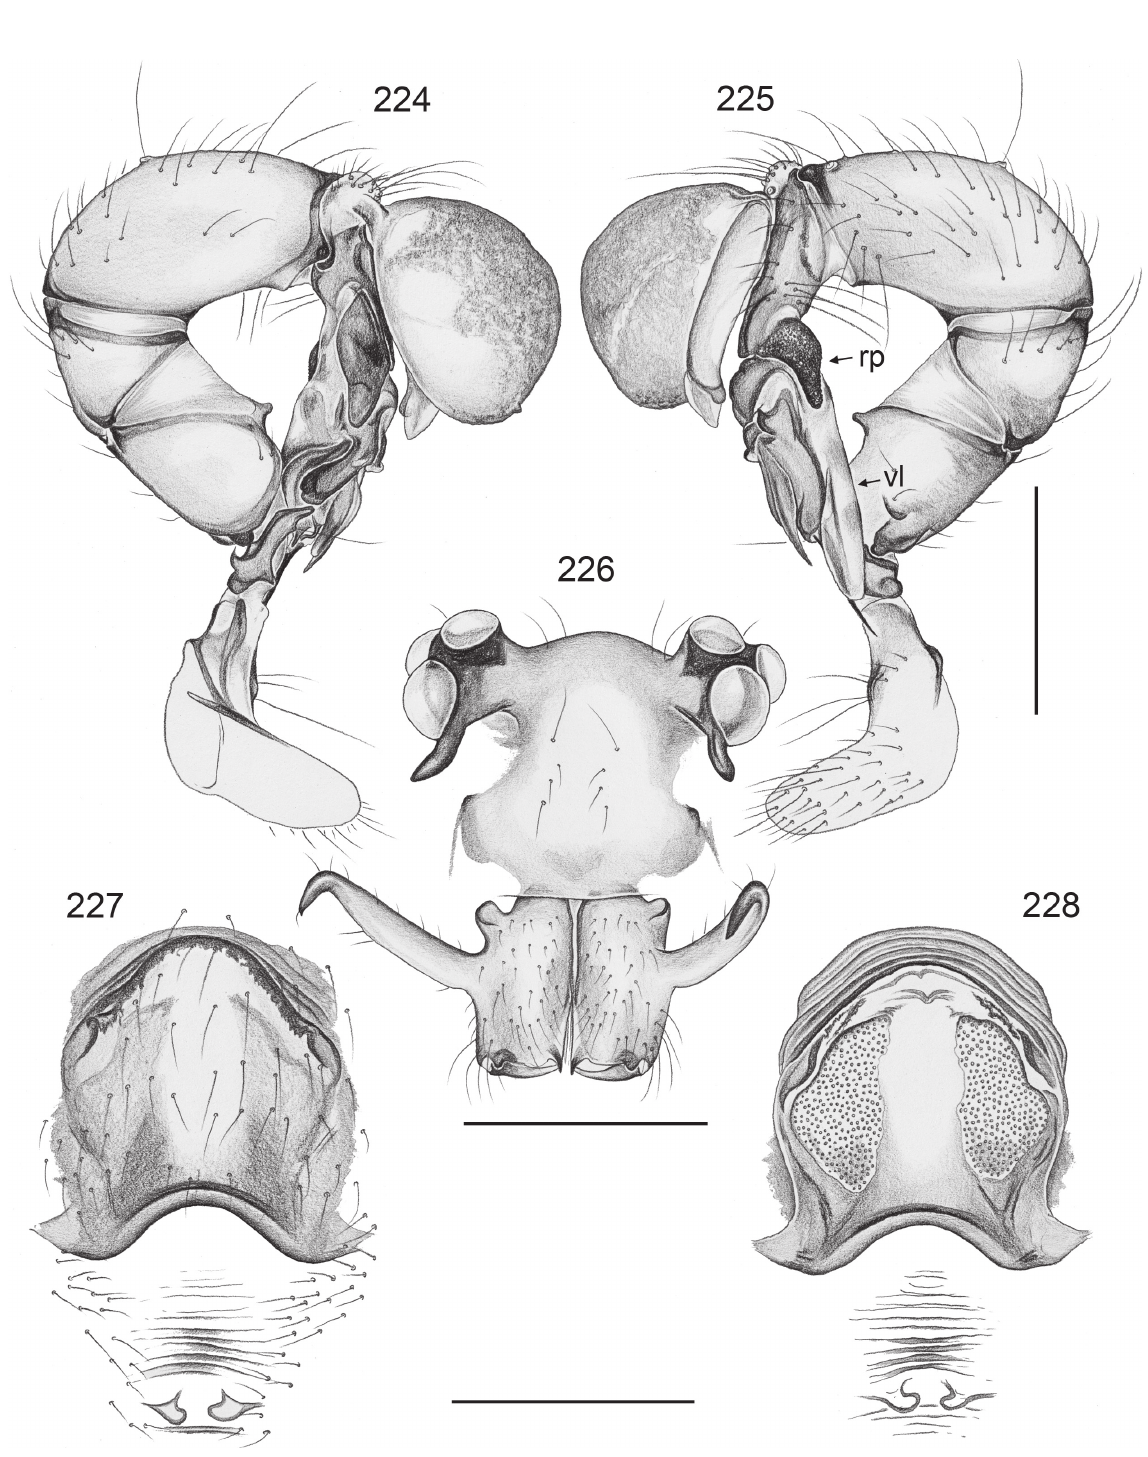
Figs 224–228. Aetana lozadae Huber, sp. nov. 224–225 . Left male palp, prolateral and retrolateral views. 226 . Male prosoma, oblique frontal view. 227–228 . Cleared female genitalia, ventral and dorsal views. rp = retrolatero-ventral process; vl = ventral lamina. Scale lines: 0.5